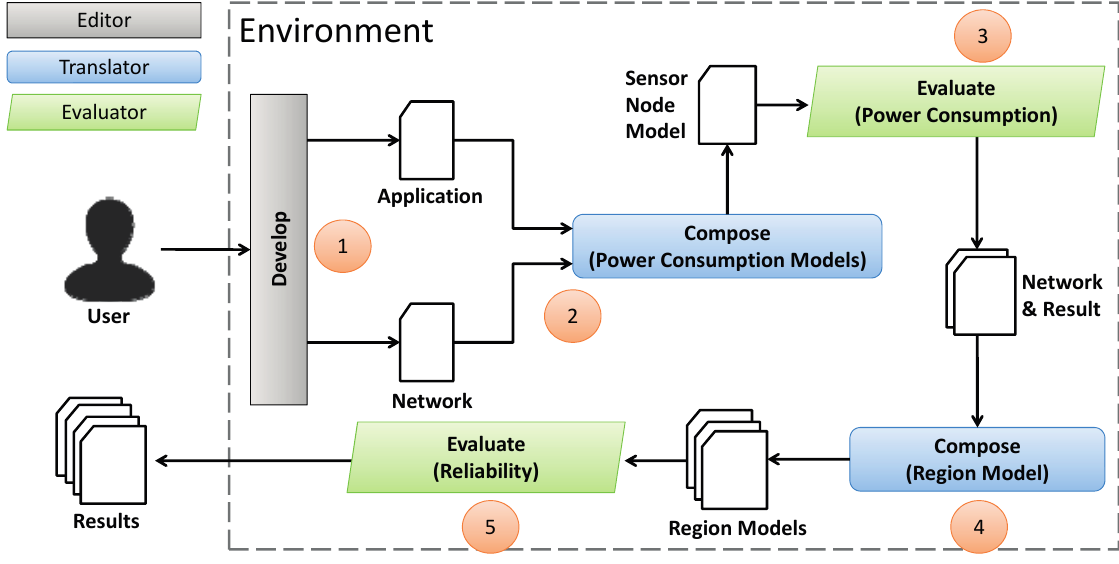
Figure 16. Step-by-step to evaluate the reliability of